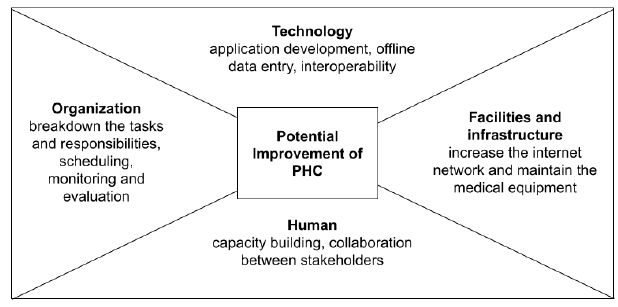
Figure 4. Potential improvement in PHC.